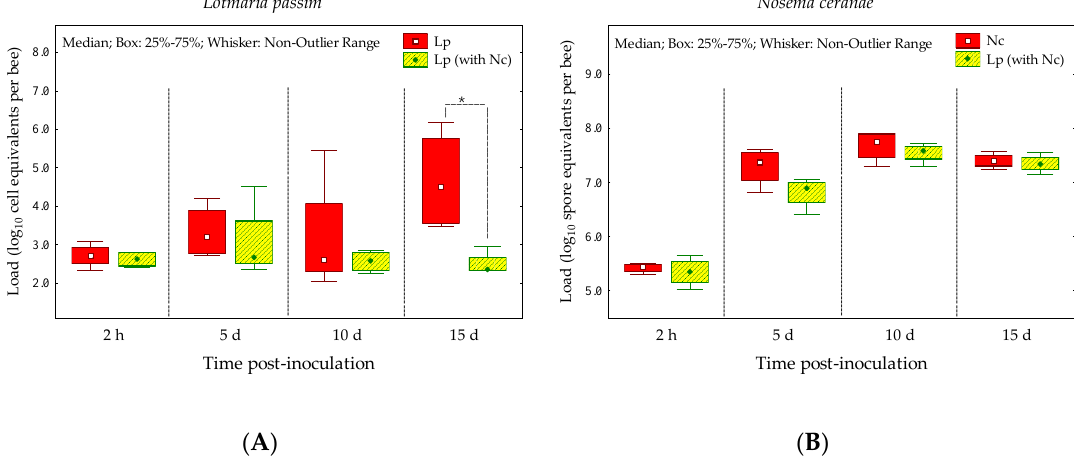
Figure 2. Lotmaria passim ( A ) and N. ceranae ( B ) loads quantified in bees naturally infected with L. passim (Lp) and bees that were L. passim -infected and inoculated with N. ceranae (Lp (with Nc)) at di ff erent times post-inoculation. Asterisks in the box plots indicate significant di ff erences (* = p < 0.05) of pathogen loads according to the Mann-Whitney U test.